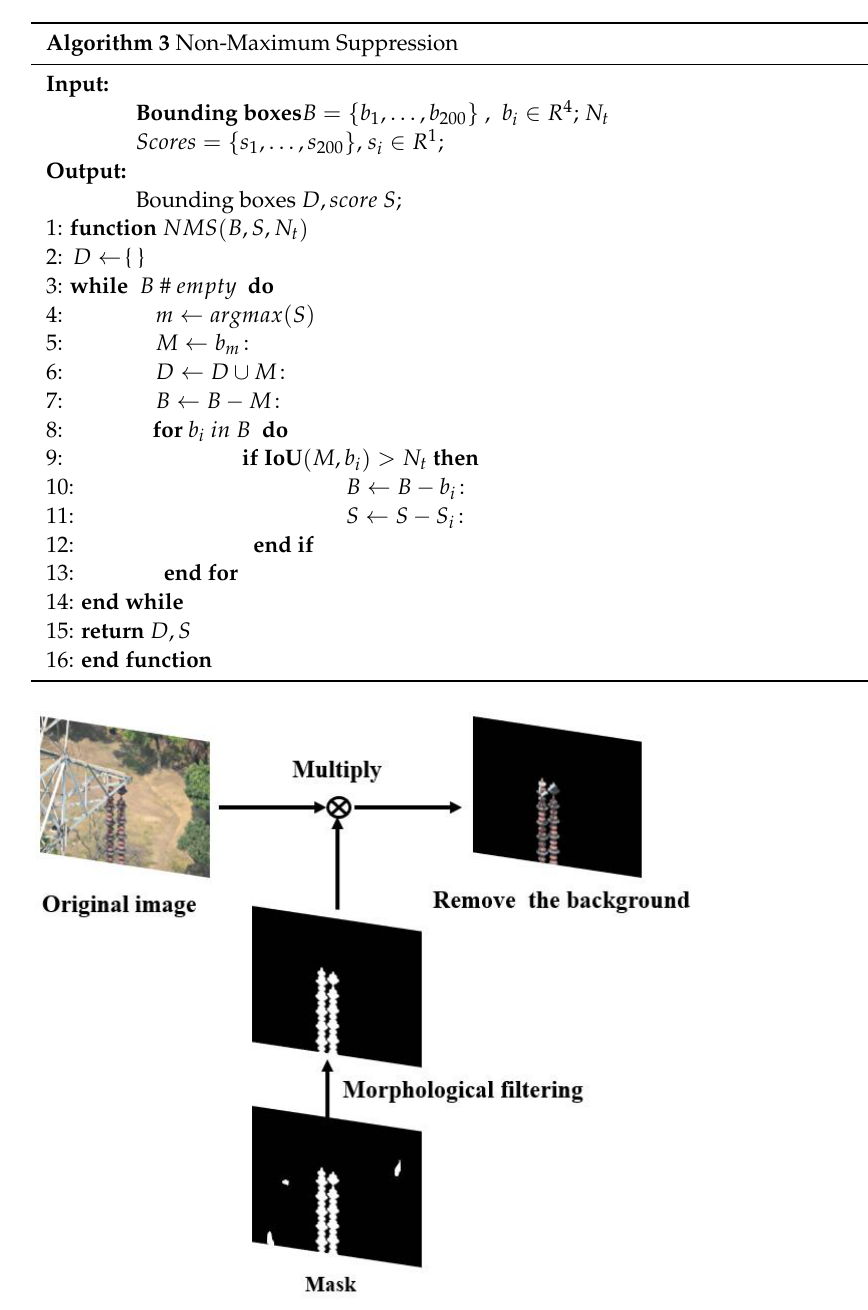
Figure 16. The mask schematic diagram.